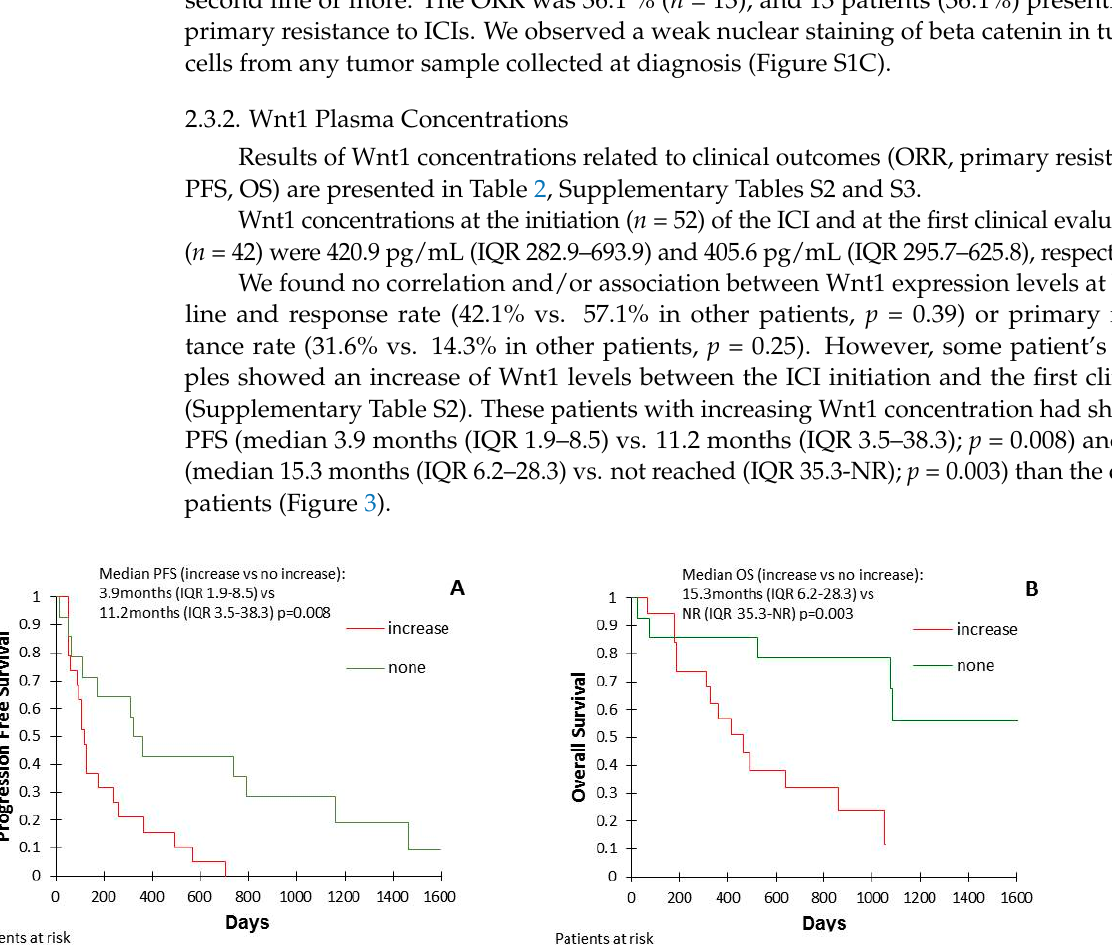
Figure 4. Wnt2 concentrations at baseline according to tumor response ( A ) and primary resistance ( B ).